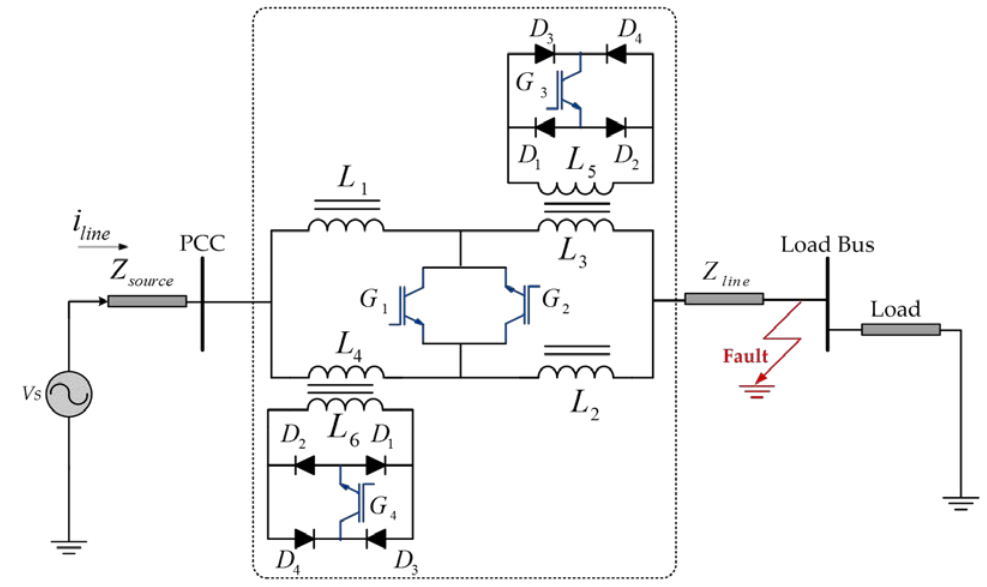
Figure 1. Proposed H bridge type fault current limiter (HBFCL) topology.